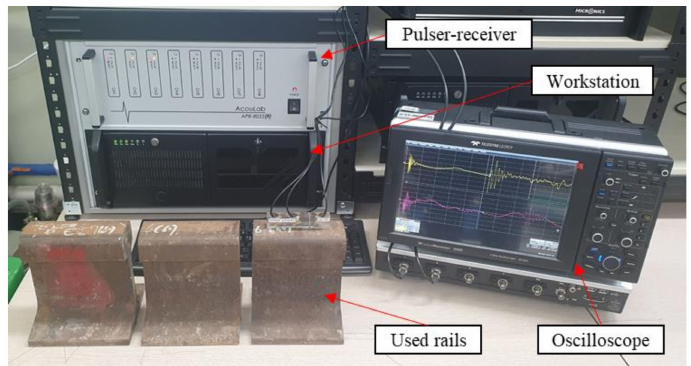
Figure 7. Photograph of the experimental setup for measuring residual stress using L CR waves.